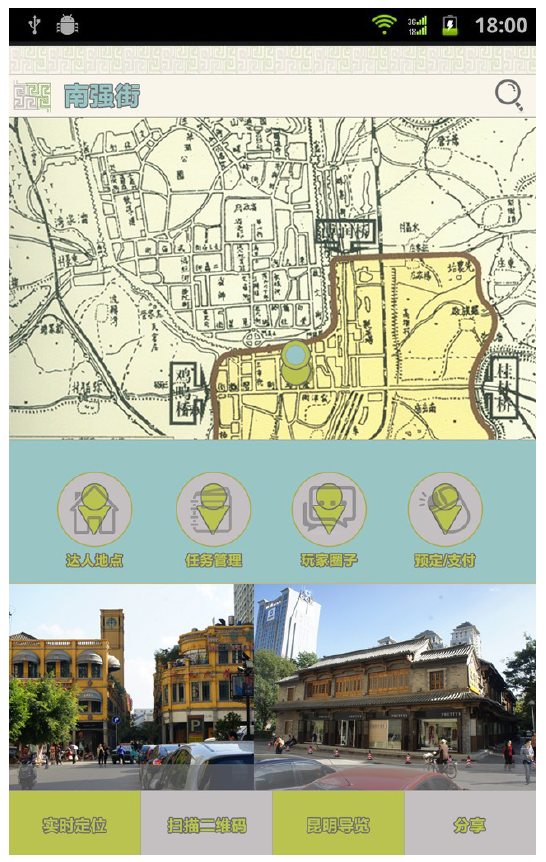
Figure 7. Tentative UI Design